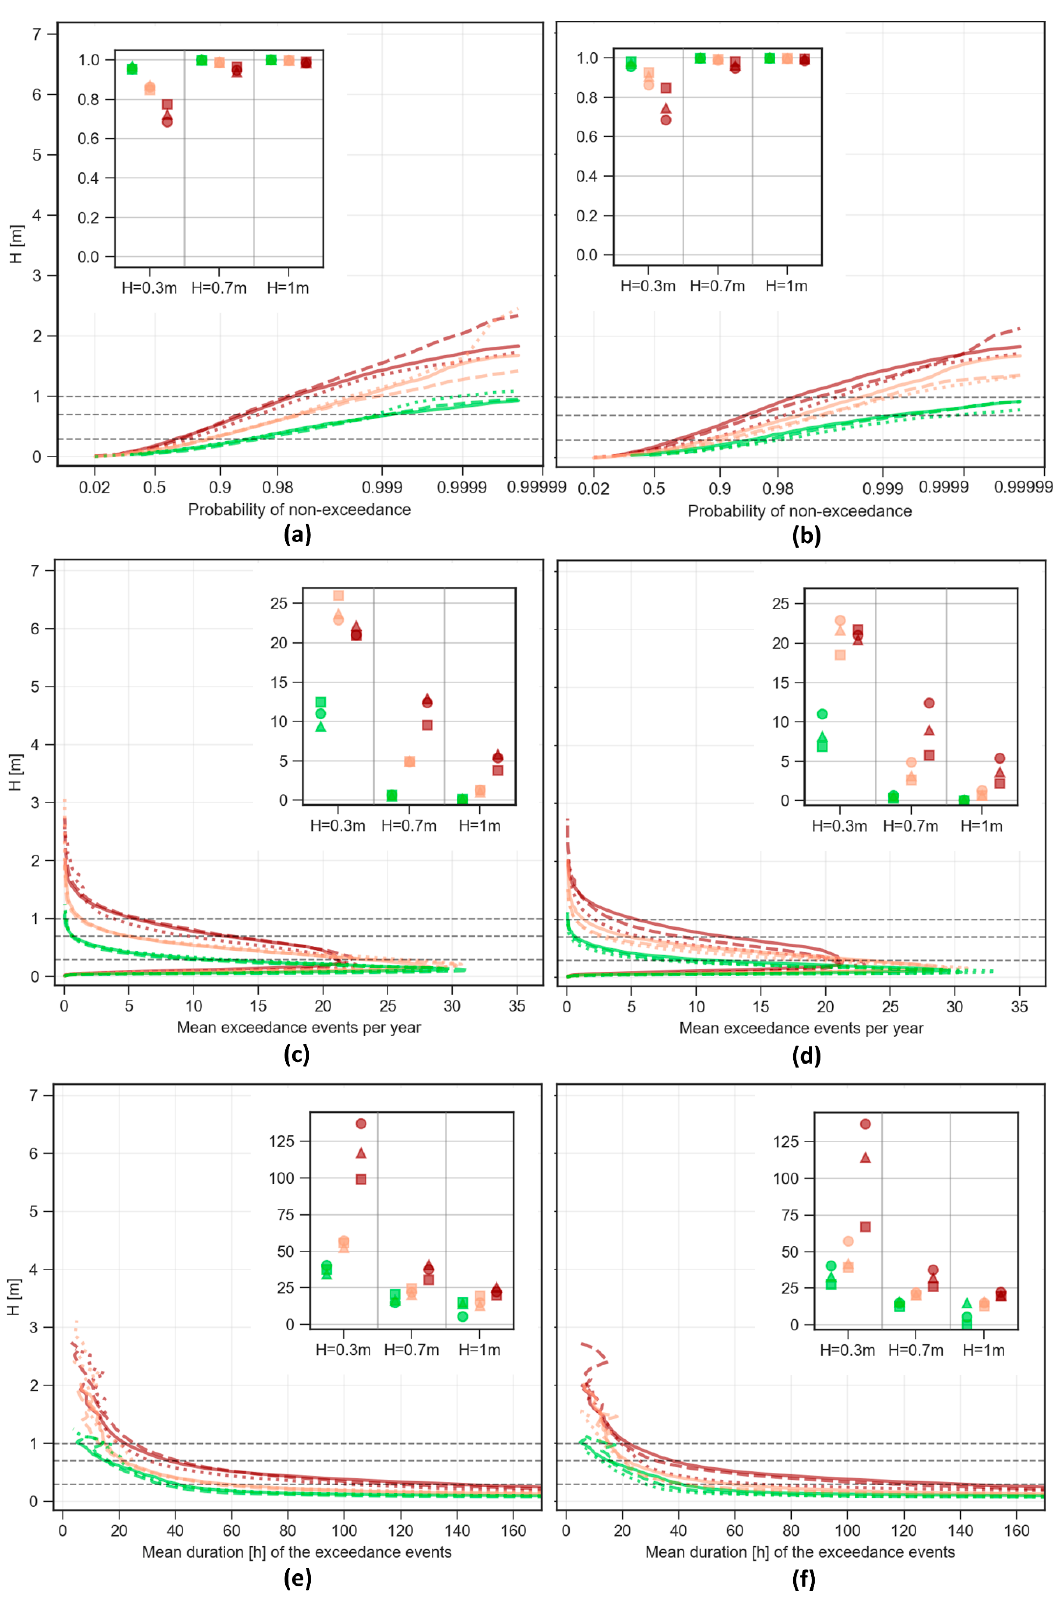
Figure A5. Comparative of operability indicators for Type 1 AOIs, including a detail of a threshold overcoming analysis for the complete sets of: ( a ) PROB , short-term; ( b ) PROB , long-term; ( c ) N , short-term; ( d ) N , long-term; ( e ) T , short-term; ( f ) T , long-term.